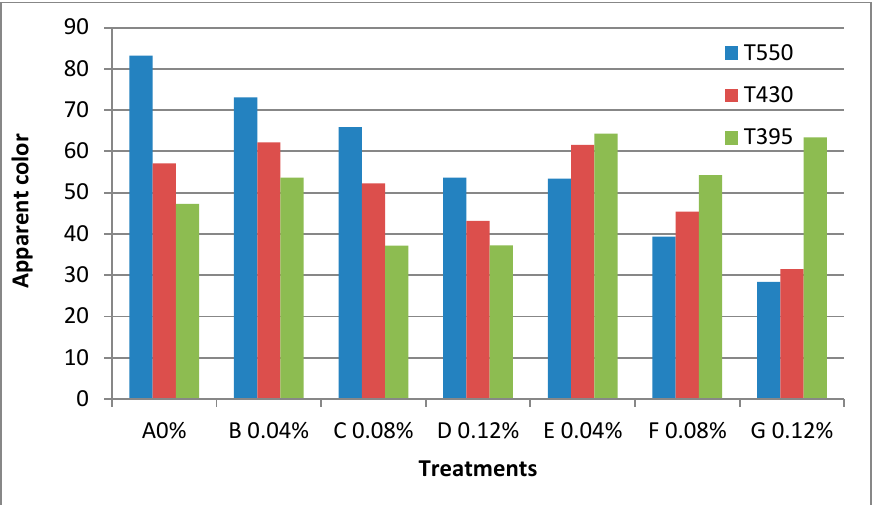
Figure 5. Measured of apparent color (Light transmittance) of the edible films prepared nano edible coating & films solution combined with ZnONPs and ZnONPs/PPE on edible films at different treatments. A 0%, B 0.04%, C 0.08%, D 0.12%, E 0.04%, F 0.08% and G 0.12%.